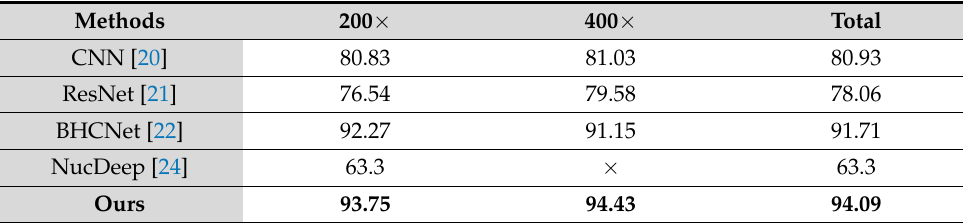
Table 5. Multi-class classification accuracy